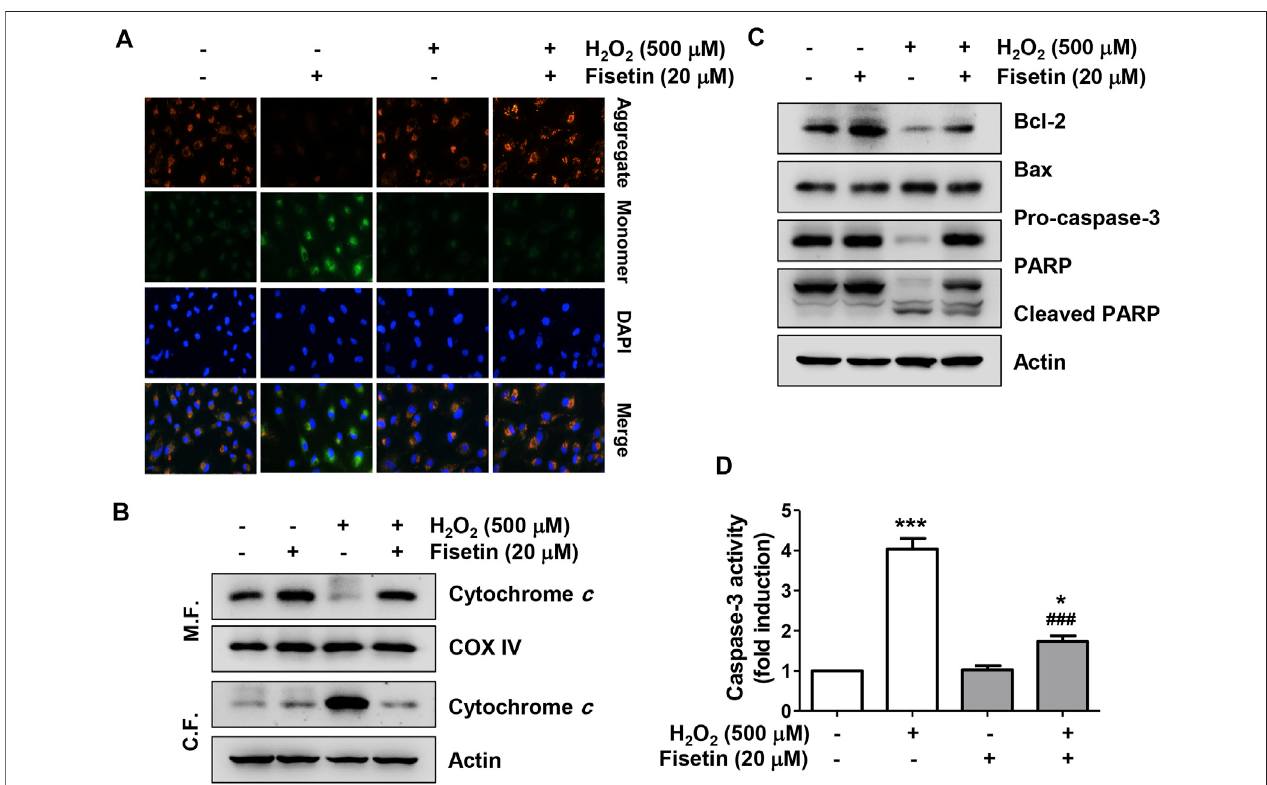
FIGURE4| Fisetinameliorated H 2 O 2 -induced mitochondrialdysfunctioninARPE-19 cells. Cellswere treatedwithor without20 μ M fi setinfor1 hand thentreated with 0.5 mM H 2 O 2 for 24 h (A) mitochondrial membrane potential (MMP) was examined by the change in JC-1-derived fl uorescence. Nuclei were counterstained with DAPI (blue). Afterstaining, representativeimagesofJC-1 aggregates (red, representing highpotential)and monomers(green,representinglowpotential)ofcellsofeach treatment group were captured using a fl uorescence microscope. Pretreatment of fi setin reversed down-regulation of the ratio of JC-1